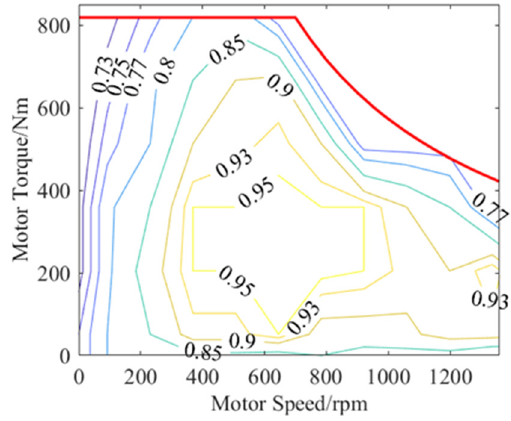
Figure 3. Wheel motor efficiency map.